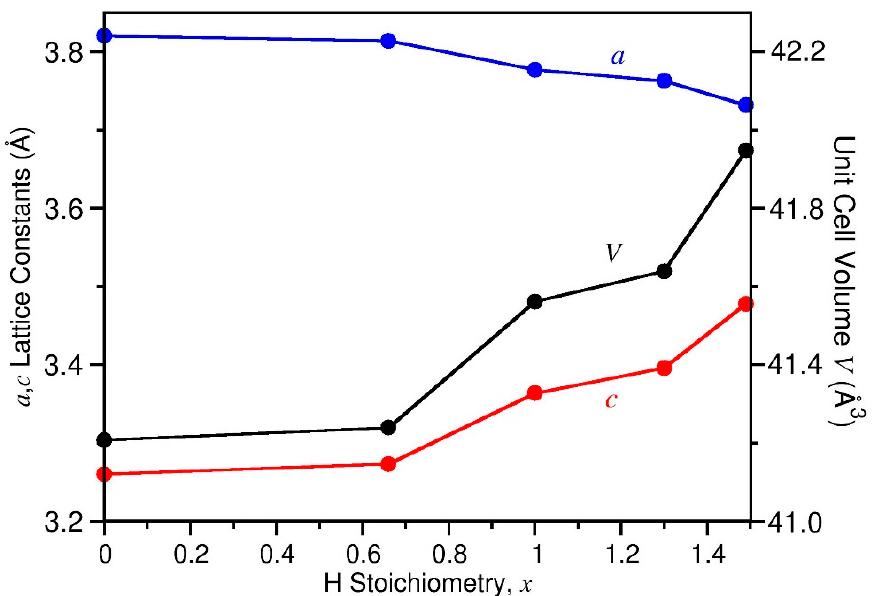
Figure 5. The hexagonal P 6/ mmm lattice constants ( a , c ) and unit cell volume ( V ) for ZrBe 2 H x near or at 500 K as functions of x , as determined by neutron powder diffraction (NPD). Values at x = 0 estimated from Ref. 1. Exact temperatures for each datapoint are listed in Table S9.